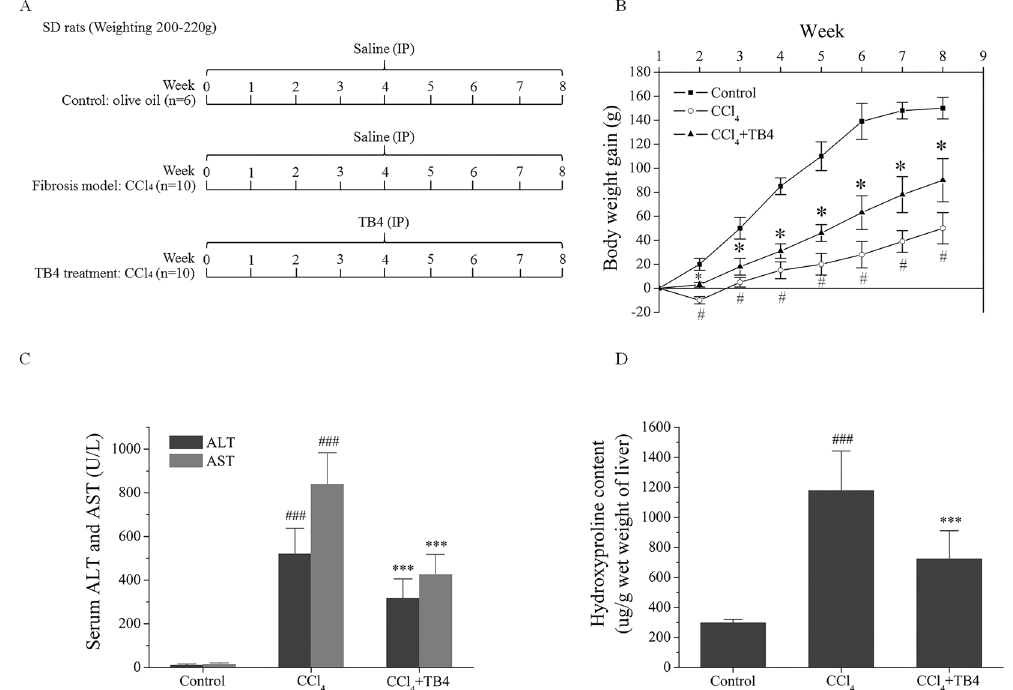
Figure 6. Experimental design and biochemical analysis. ( A ) Experimental design of the schedule for CCl 4 and thymosin β 4 (TB4). ( B ) Effect of TB4 on rat body weights; the body weight gains in CCl 4 -treated rats were significantly lower than those in control and CCl 4 plus TB4 treated rats. # P < 0.05 vs. control group; * P < 0.05